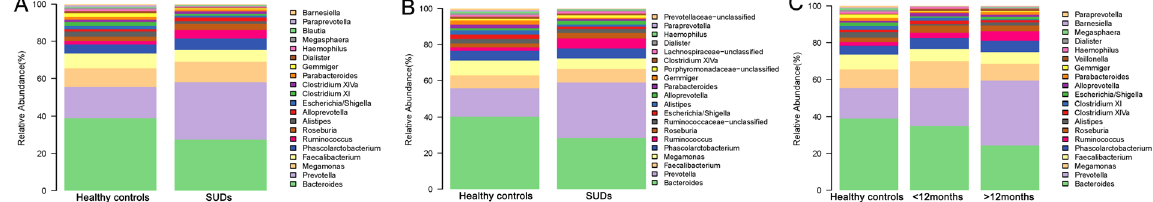
Figure 2. Genus-level taxonomic distribution of intestinal microbiota and top 20 genera in ( A ) 45 SUDs vs 48 HCs, ( B ) 29 age-matched SUDs vs 28 age-matched HCs, and ( C ) long-term SUDs vs short-term SUDs. Stacked columns for each of the group show the mean of abundance of a given genus as a percentage of the total bacterial sequences in the corresponding group.